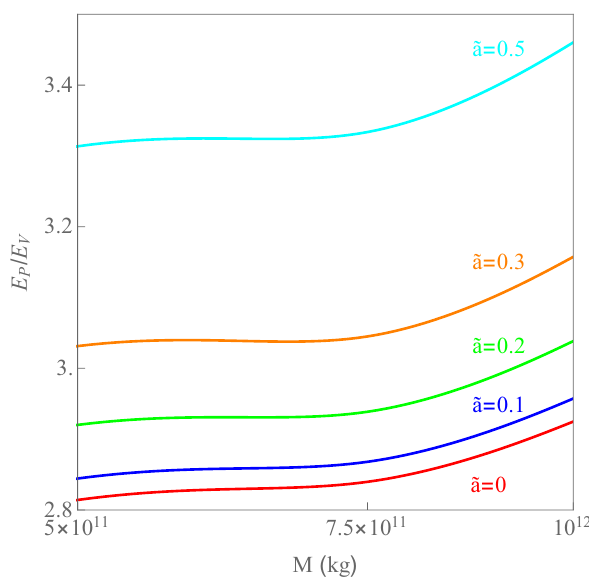
Figure 13 . Ratio E P /E V as a function of the PBH mass, computed using the semi-analytical method, for ˜ a = 0 , 0 . 1 , 0 . 2 , 0 . 3 , 0 . 5 (red, blue, green, orange and cyan, respectively). PBH ( ˜ a (cid:28) 1 ) from one that is spinning with ˜ a & 0 . 2 . This methodology fails only in